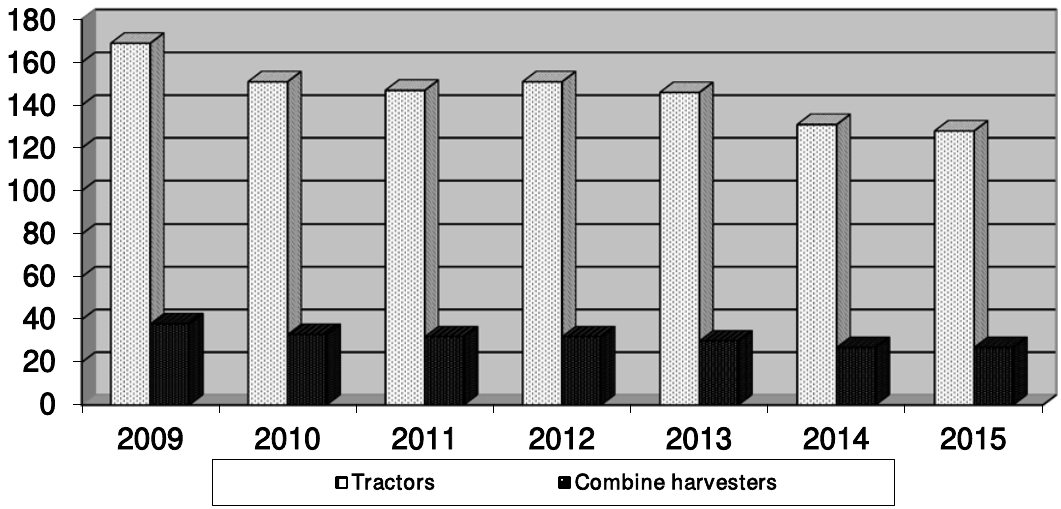
Fig. 1. The fleet of tractors and combine harvesters in agricultural enterprises of Ukraine (end of the year), thousand units